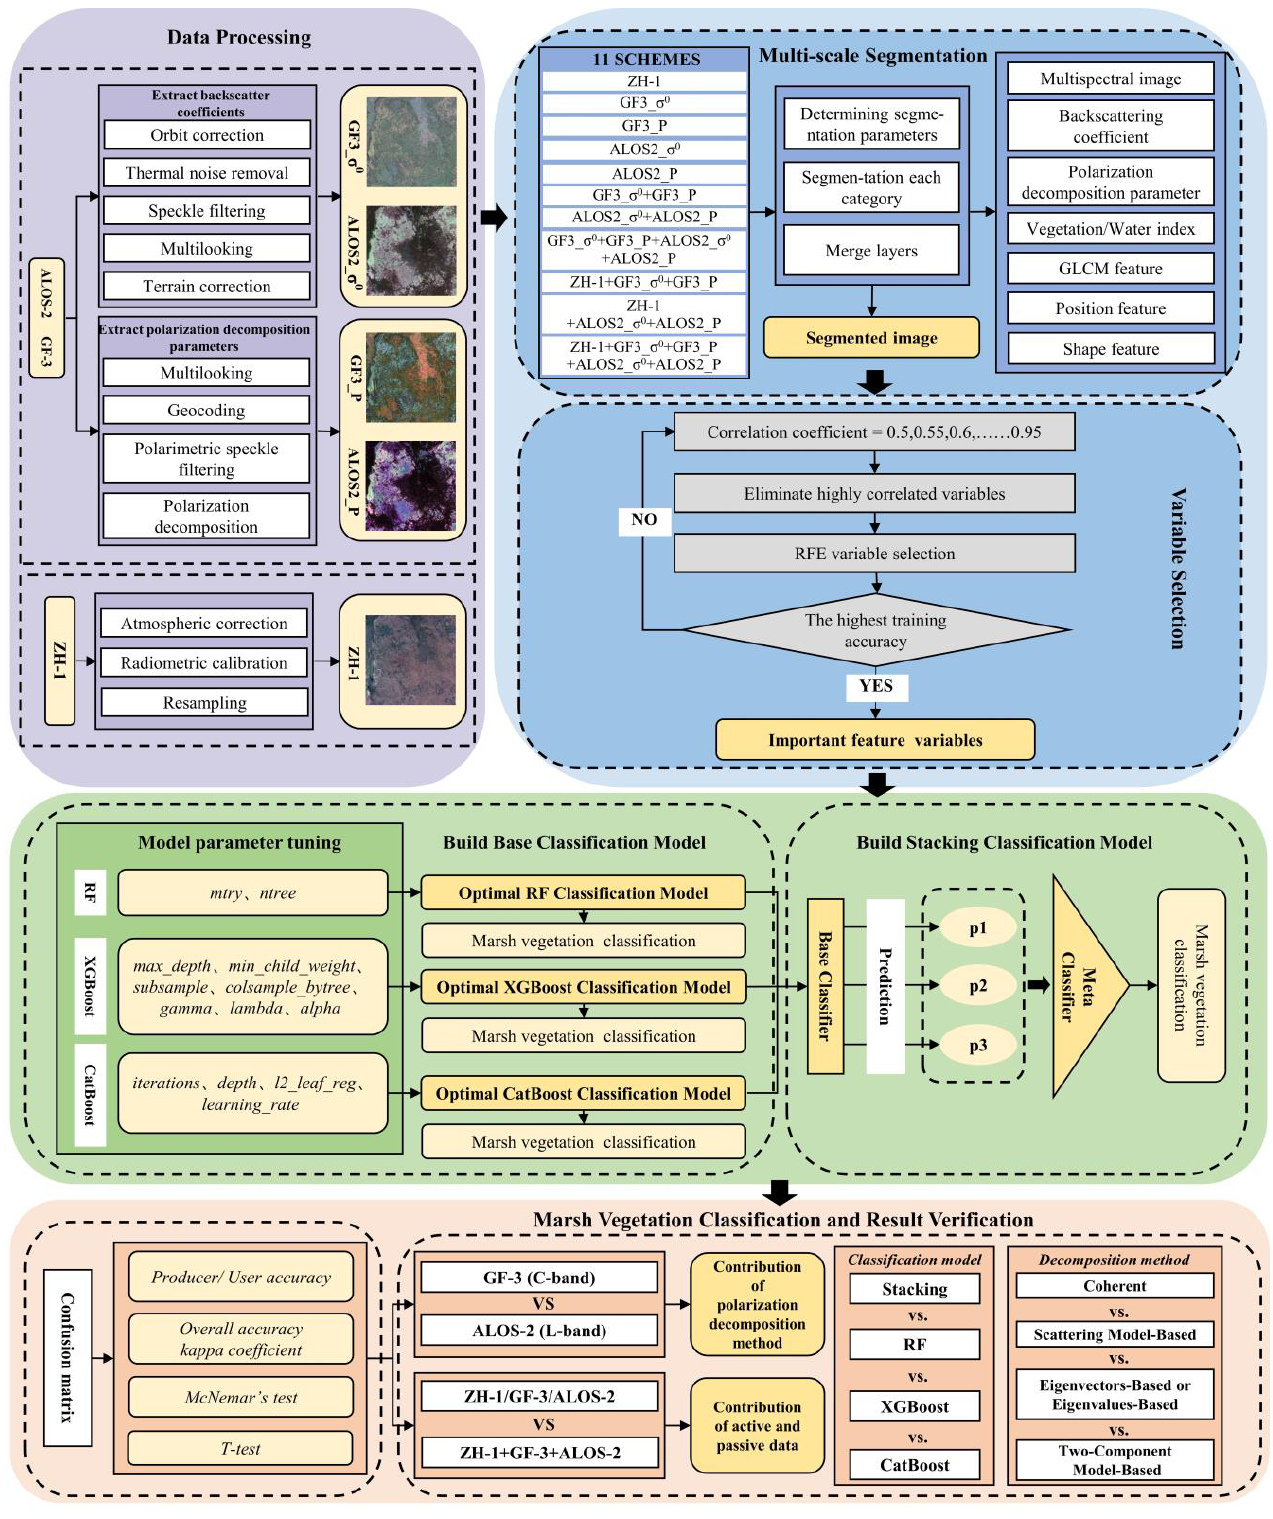
Figure 2. Workflow of this